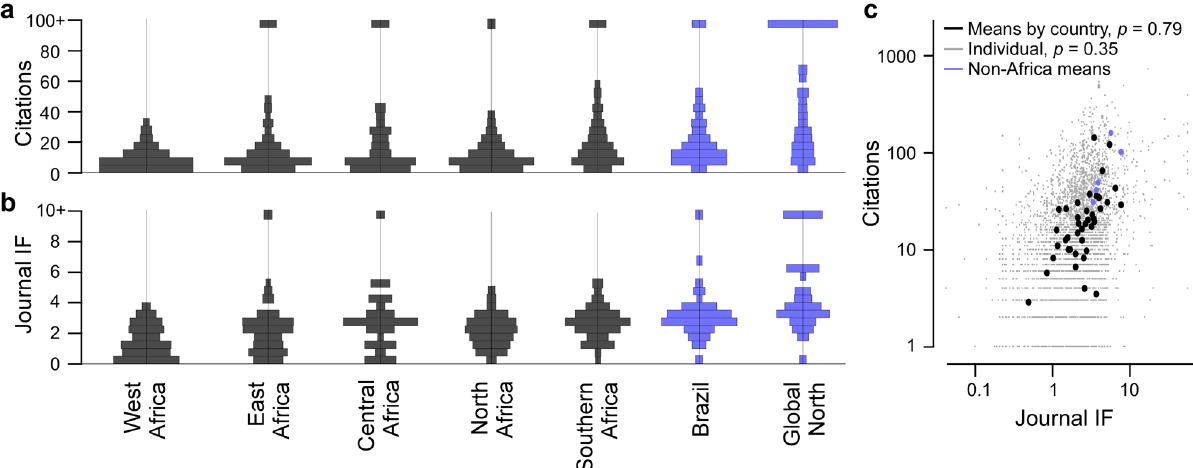
Fig. 2 Citations and journal impact factors. a , b Area-normalised histograms of citations ( a ) and the publishing journal ’ s impact factor (IF, b ) of all papers from different African and non-African regions, as indicated. In each case, all citations above ≥ 95, and IF above ≥ 9.5 were allocated to a single bin (top). c Citations plotted against IF for every paper in the database (small grey dots), and for means by country (large dots), as indicated. Linear correlation coef fi cients as indicated. Source data are provided as a Source Data fi